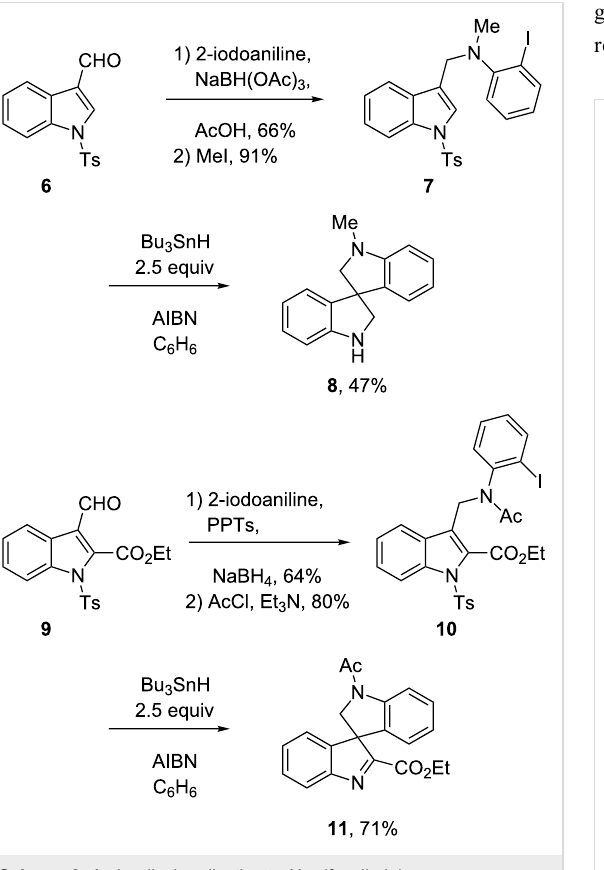
Scheme 2: Aryl radical cyclization to N -sulfonylindoles.